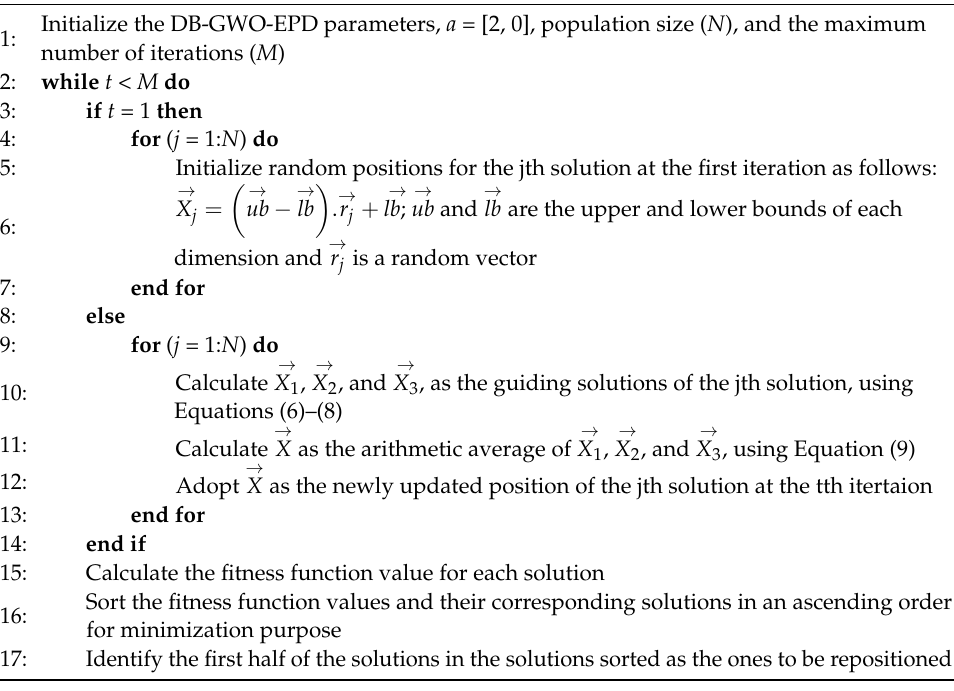
Algorithm 1 : Pseudo-code of the DB-GWO-EPD